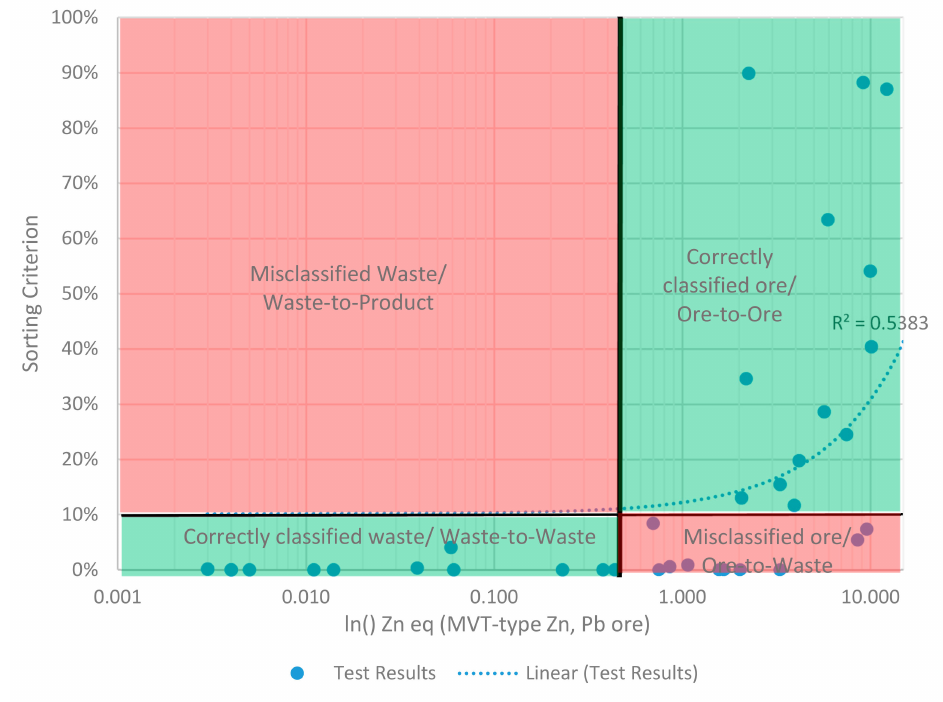
Figure 3. Example of bench-scale test results to describe detection e ffi ciency, modified after Crosby and Buxton